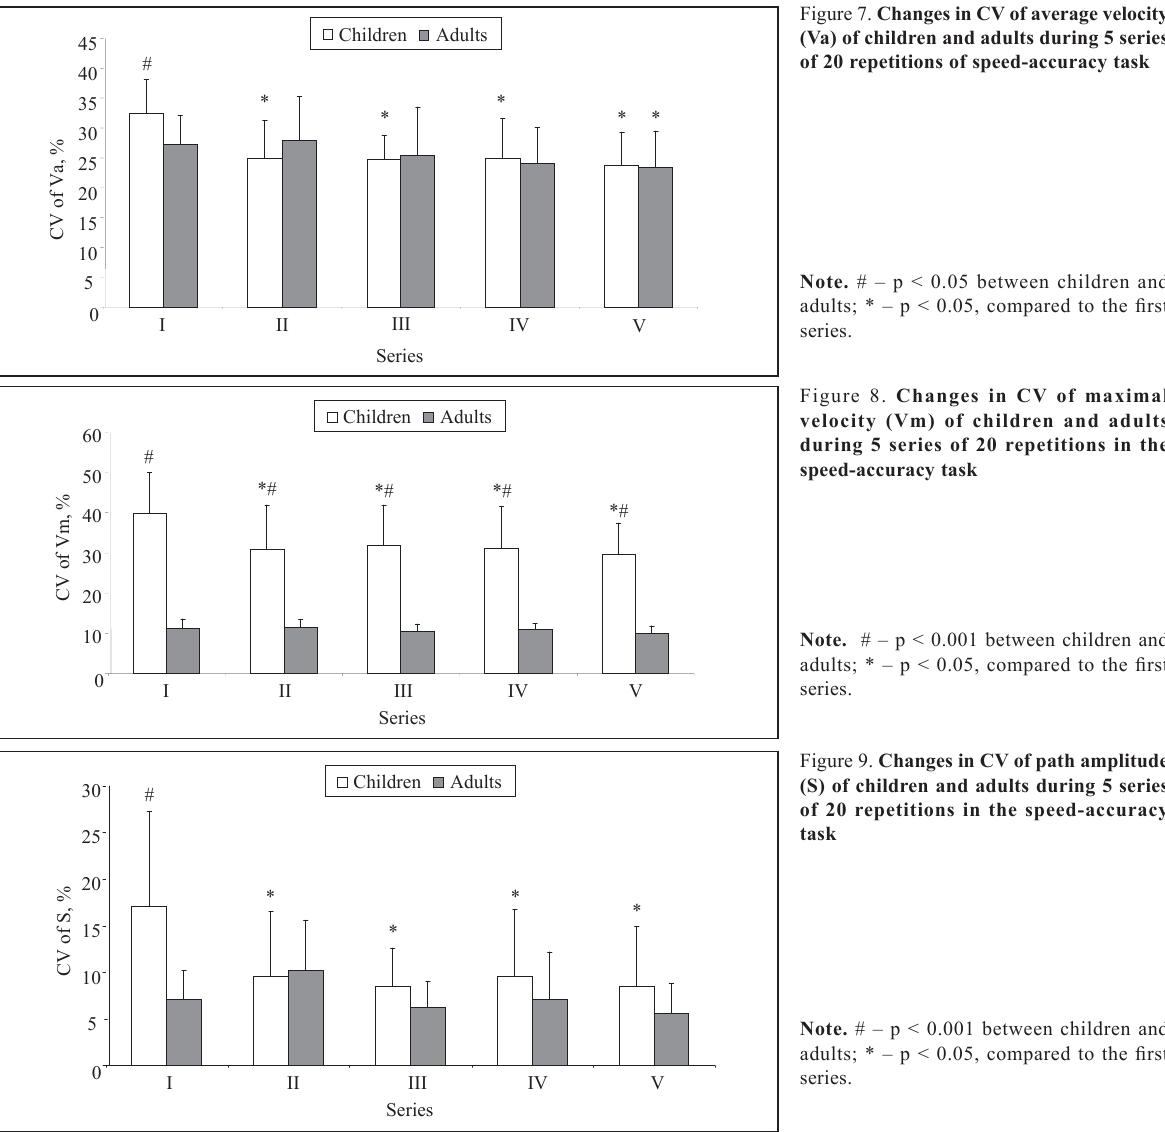
Note. # – p < 0.001 between children and adults; * – p < 0.05, compared to the fi rst